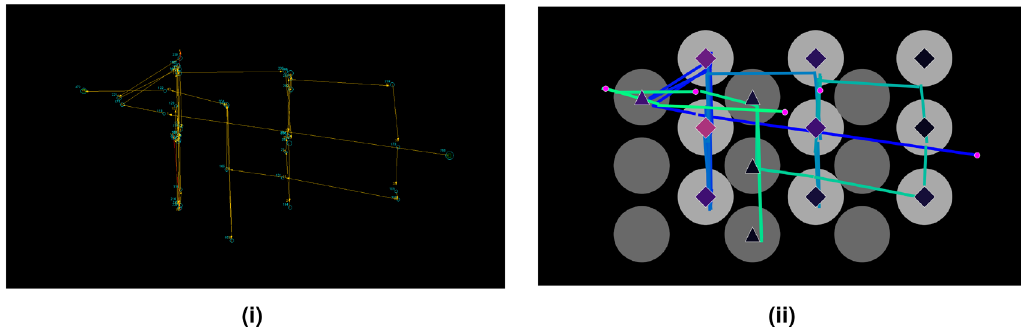
Figure 2. ( i ) A prototypical representation of a scanpath displaying fixation locations, fixation duration, and saccades. ( ii ) An example of how we represent the data using scanpaths to increase the salience of information to the models. The circles represent the location of the payoffs for both the participant (light grey) and the opponent (dark grey). We use sequential colourmaps to represent the temporal evolution of the linear saccades and to display information regarding fixations to the